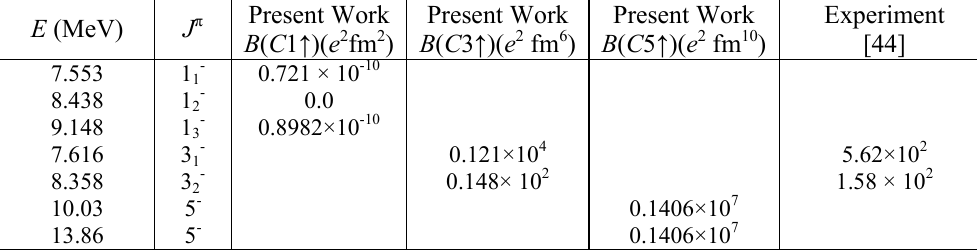
Table 3: Comparison of experimental transition probabilities with predictions of Present Work for negative- parity states in 24